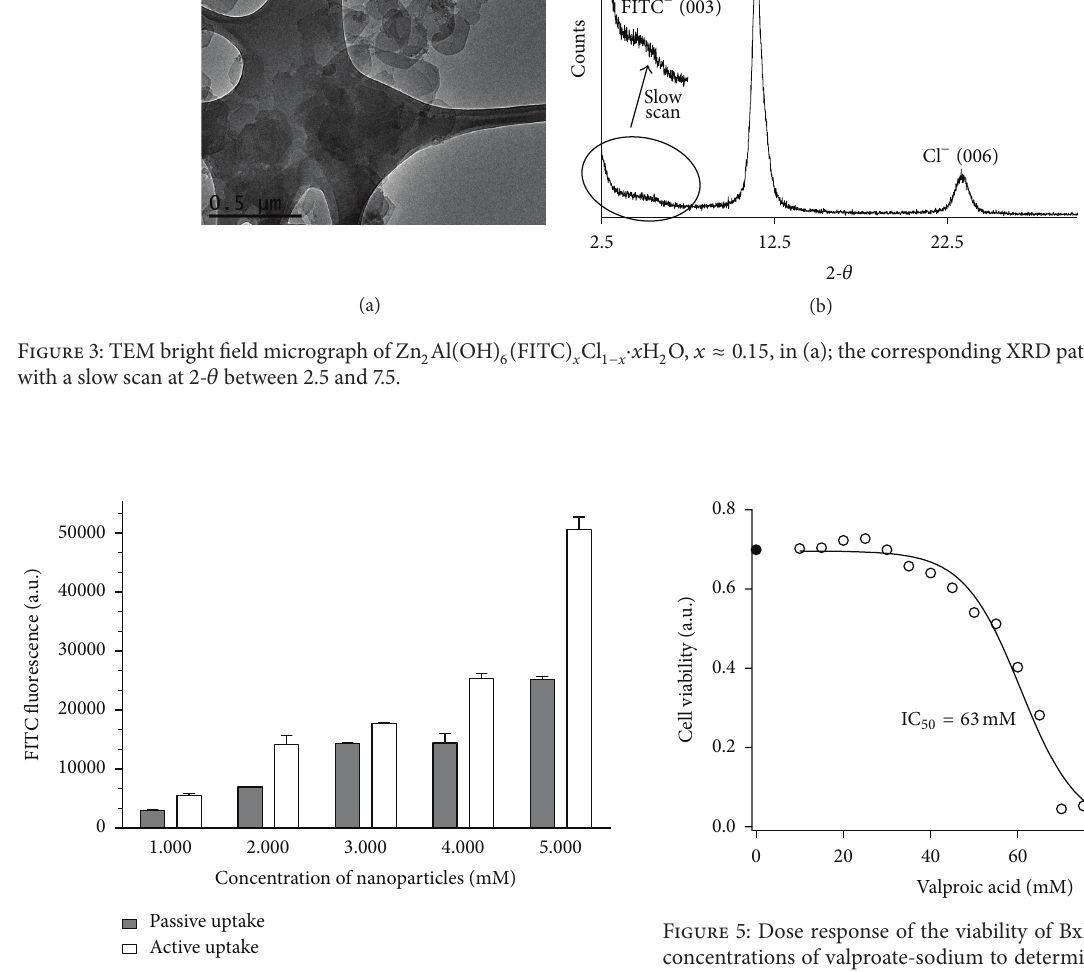
Figure 4: Assessment of energy dependence of the uptake of nanoparticles. Fluorescence from BxPC3 cell treated with (Zn, Al, FITC)-LDH nanoparticles at either 37 ∘ C (active uptake) or at 4 ∘ C (passive uptake). 𝑥 -axis represents the concentration of the nanoparticles in terms of Al content.